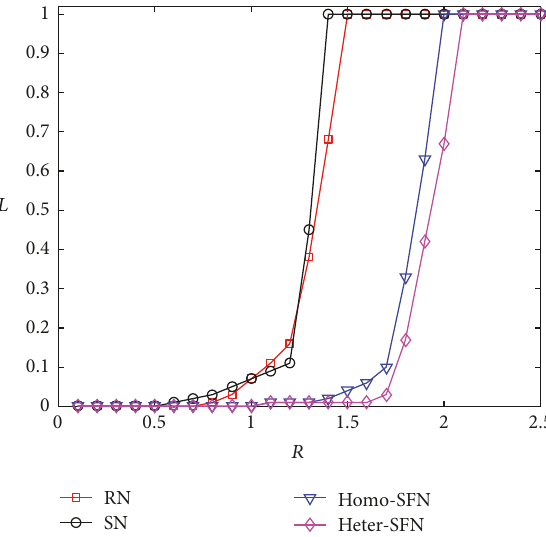
Figure 5: 𝐿 - 𝑅 relation curve under random attack (𝜀 = 0.6) .